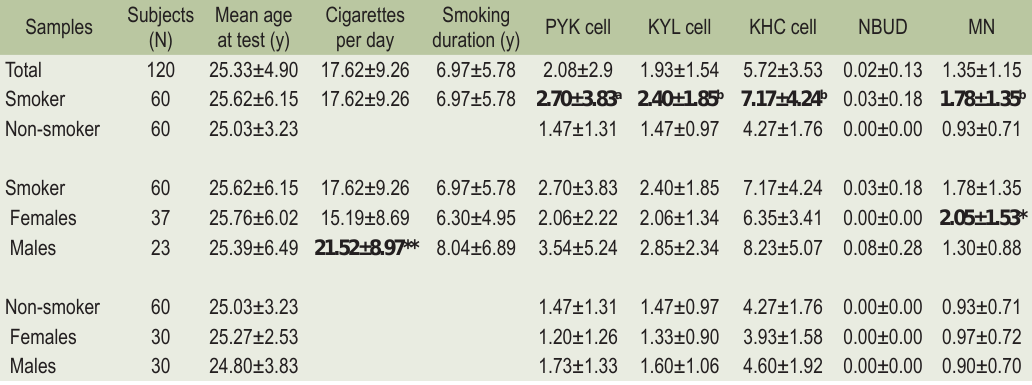
TABLE 3. Comparison of cytogenetic biomarker frequencies by strati fi cation of sex and smoking status. All values are given as mean ± SD per